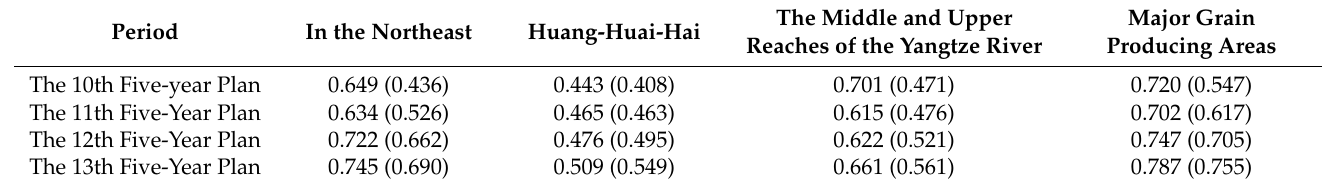
Figure 7. Evolving trend of grain production resource allocation efficiency in the three major regions from 2000 to 2019.